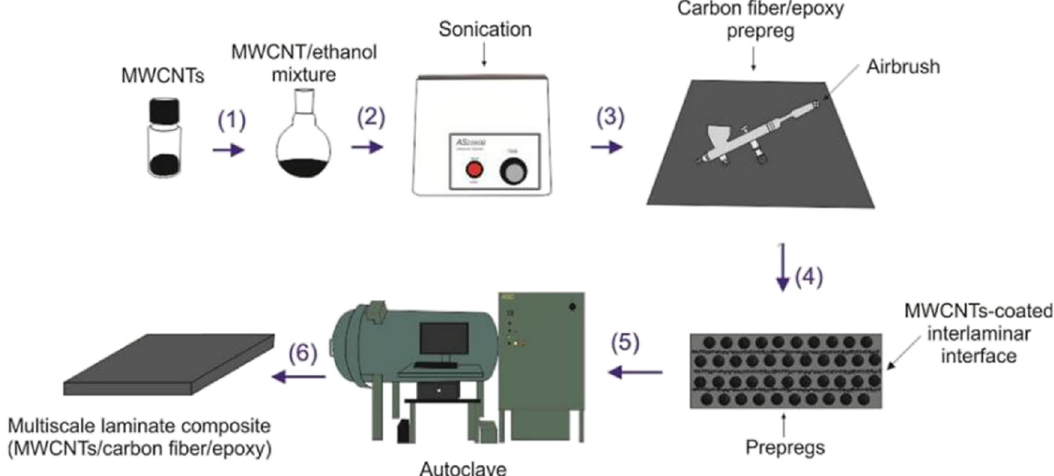
Figure 10: The schematic of spraying solvent method used for incorporation of MWCNTs onto prepreg and manufacturing of multiscale laminate composite [ 57 ]